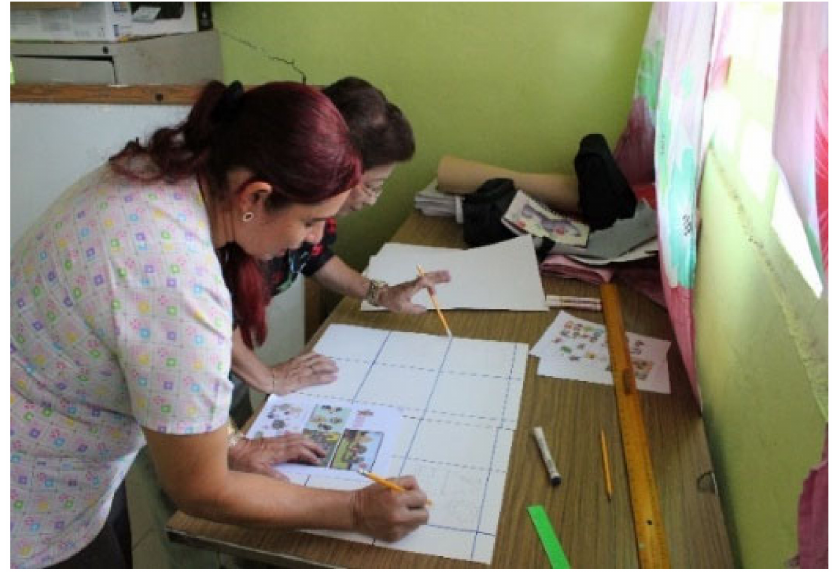
Figure 1. Practical workshop for making